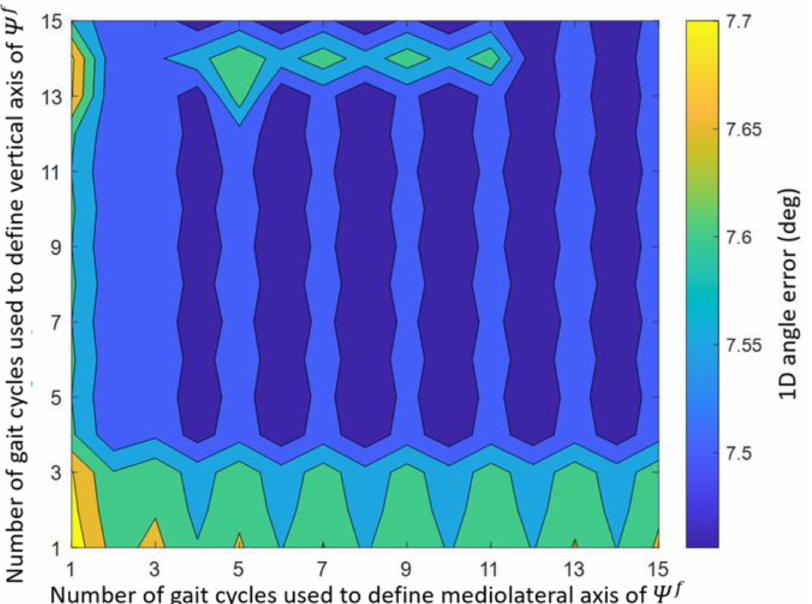
Figure 7. Effect of the number of gait cycles used to determine the mediolateral Equation (4a) and vertical axis Equation (4b) of Ψ f on the 1D angle error. The 1D angle error represents the angle of the axis-angle representation of the difference in orientation between DFOD and OMCS.